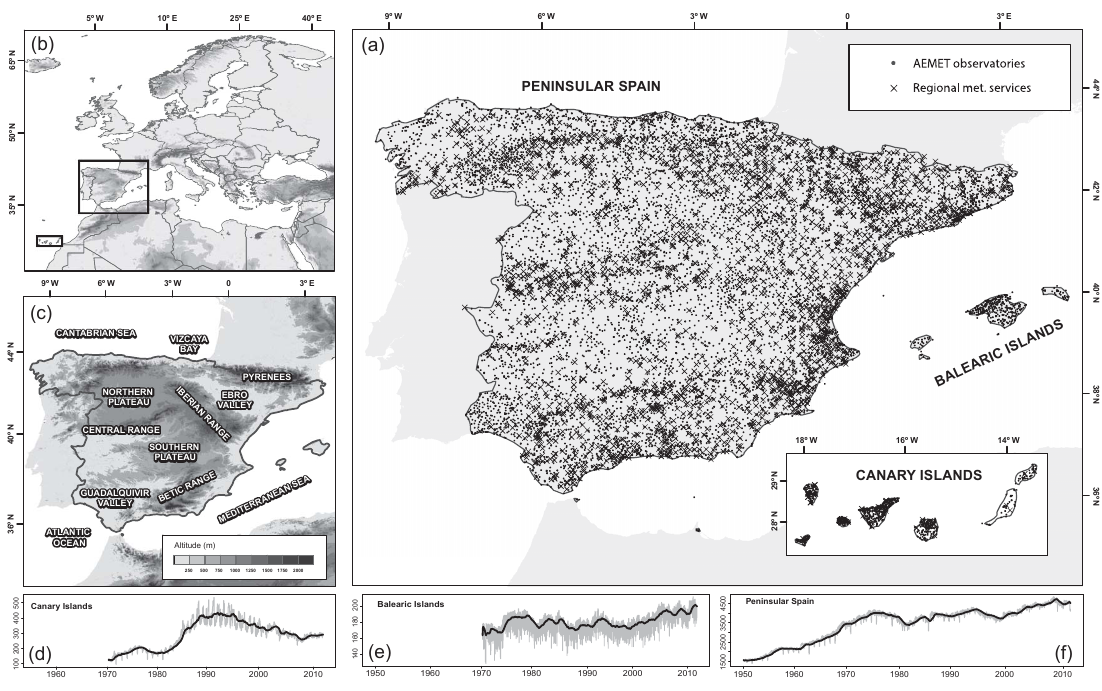
Figure 1. Location of the precipitation stations used (a) , location of Spain in Europe context (b) and geographical references used in the text (c) . Number of daily available observatories (grey lines), and its moving average of 365 days (black lines) in the Canary Islands (d) , Balearic Islands (e) and peninsular Spain (f) .